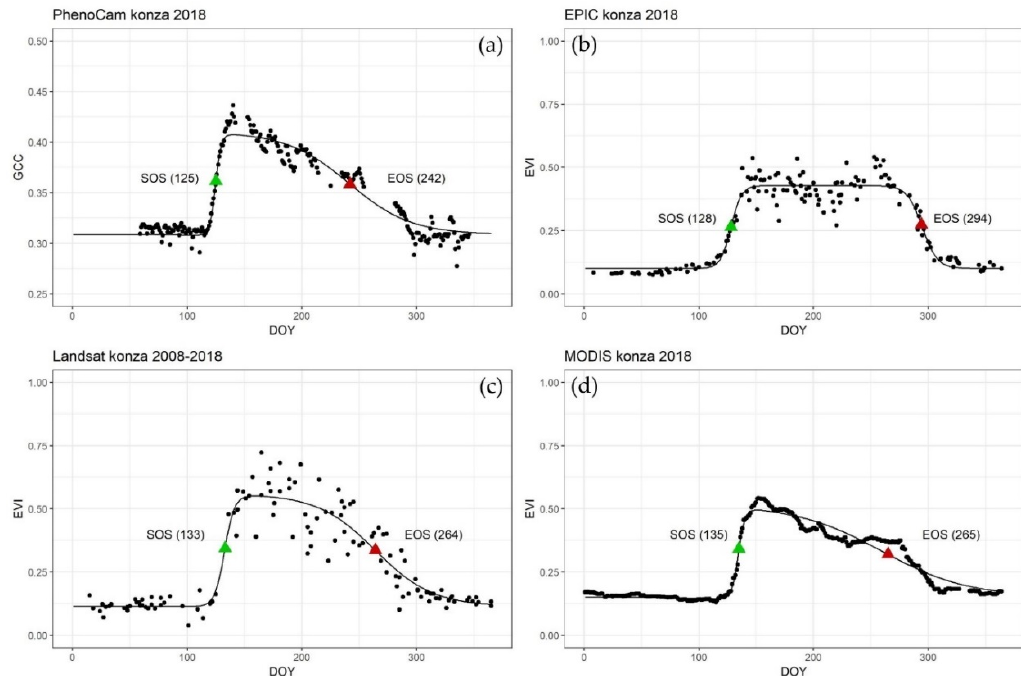
Figure A3. Derived vegetation phenology indicators of SOS and EOS from EVI for evergreen needleleaf study site ‘howland1’ based on ( a ) PhenoCam, ( b ) EPIC, ( c ) Landsat, and ( d ) MODIS observations. The green triangles indicate SOS, and the red triangles indicate EOS for each time series. The y-axis scale was kept constant for Landsat, MODIS, and EPIC, but adjusted for PhenoCam to better show the shape of the curve.